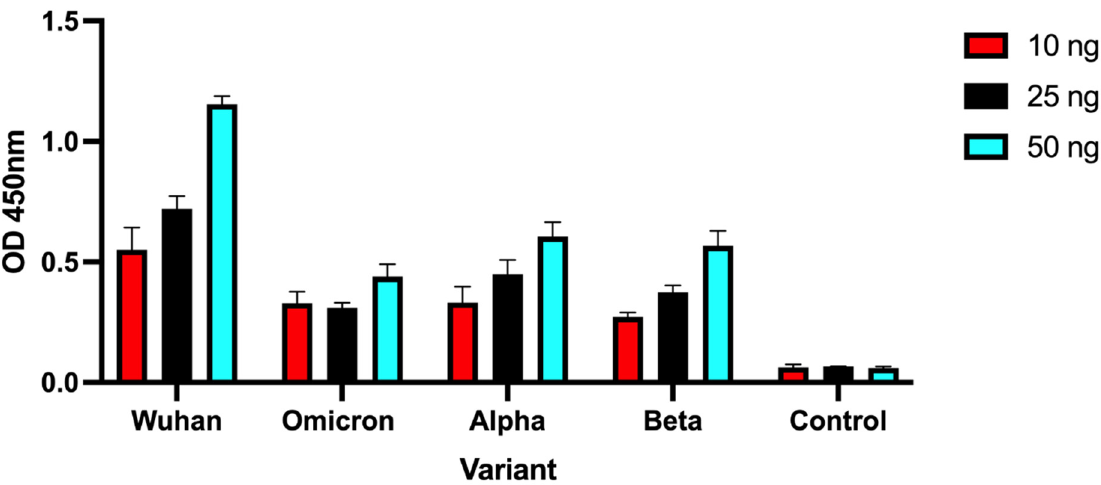
Figure 2. Detection of spike protein variants using engineered mini protein. Different quantities of spike RBD variants or Bovine Serum Albumin (control) were immobilized into wells and allowed to bind biotinylated mini protein. Detection was achieved by the addition of streptavidin-HRP and peroxidase substrate. Bars represent the average OD measurements performed in duplicates, and error bars represent standard deviation.